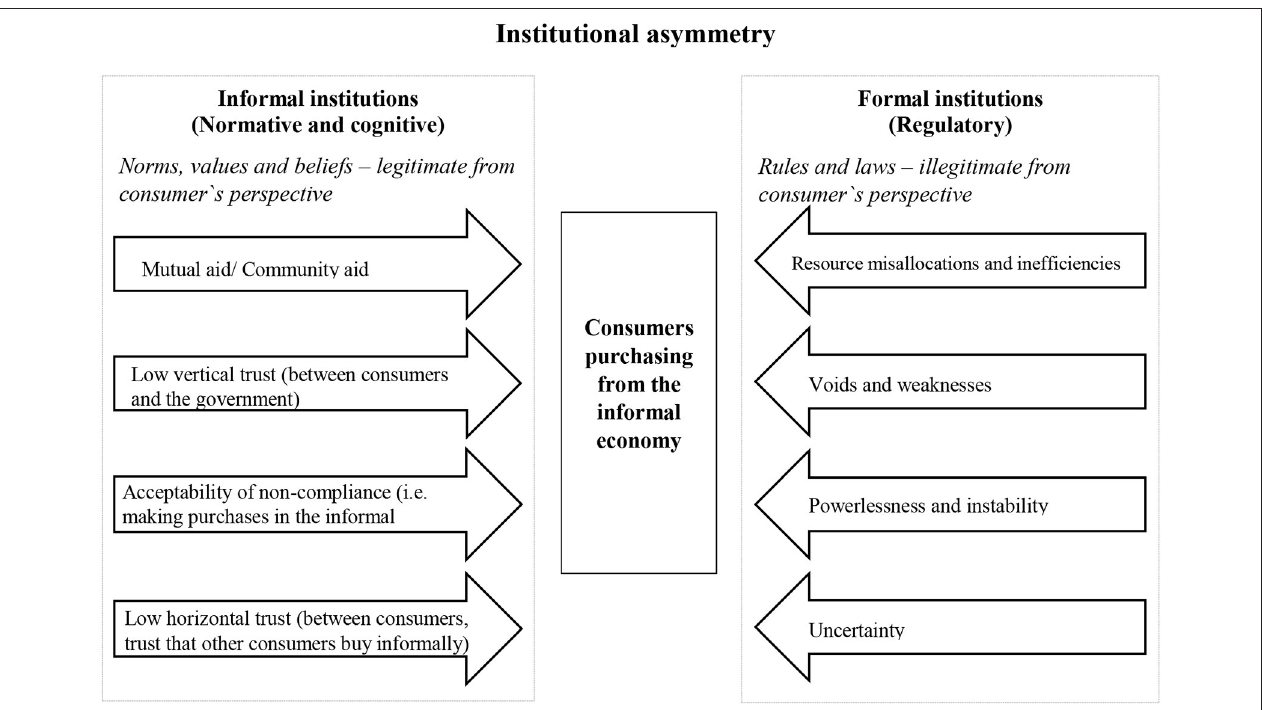
FIGURE 2 | Consumer purchase model for testing the third wave of thought in institutional